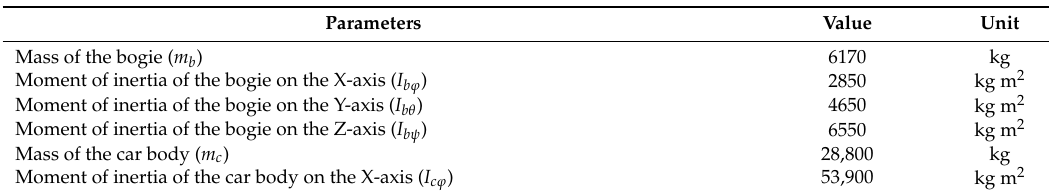
Table 3. The major parameters of the monorail vehicle